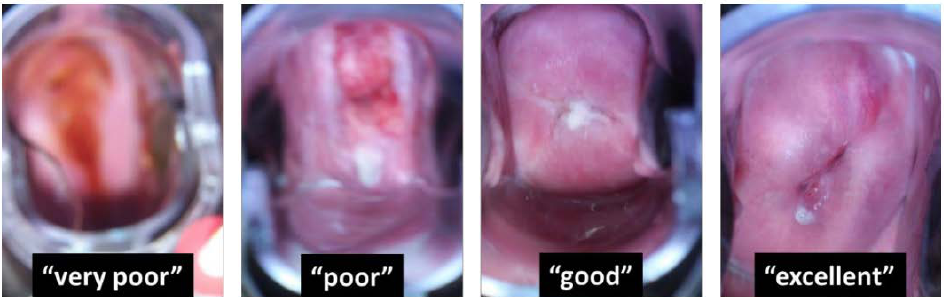
Figure 10. Example of images taken with the EVA system showing the different quality of images, ranging from very poor to excellent (Reprinted with permission from Ref. [59]. Copyright 2018 So- ciety of Photo-Optical Instrumentation Engineers (SPIE)).